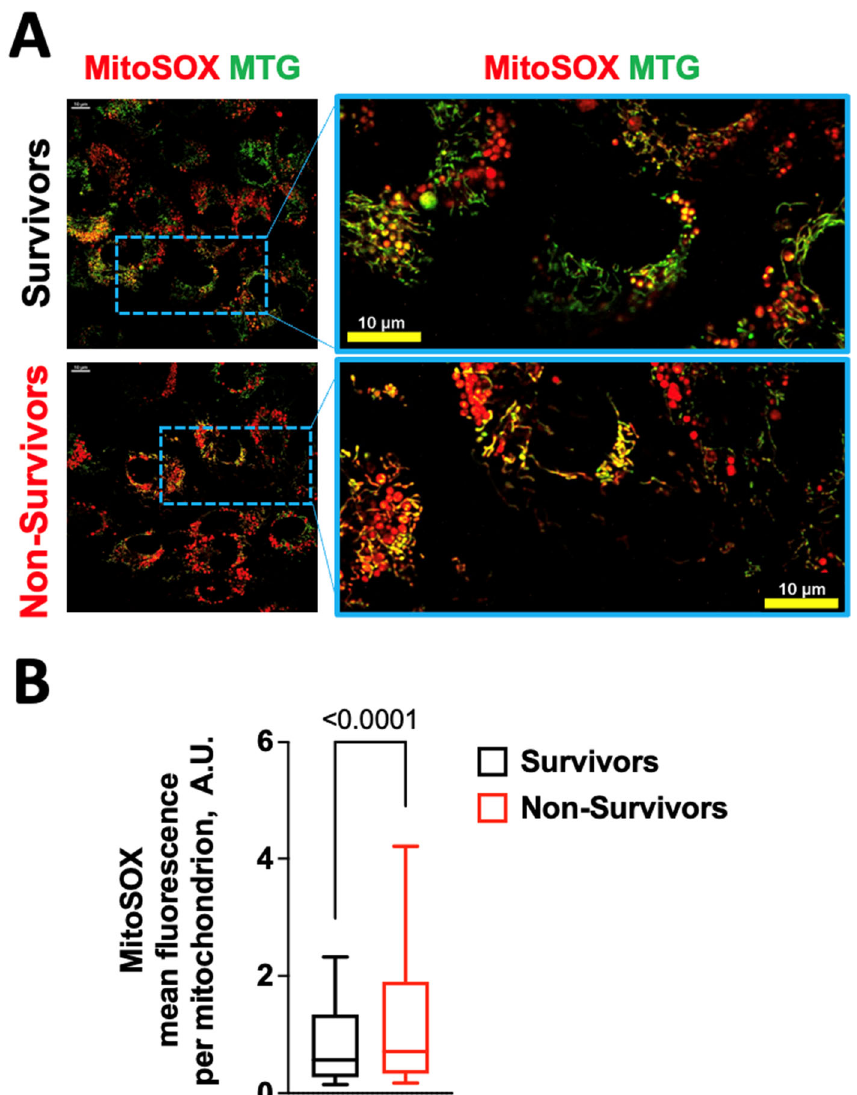
Figure 2. Serum from patients who did not survive COVID-19 increases mitochondrial ROS production. ( A ) Representative microphotographs of MitoSOX Red and MitoTracker Green FM (MTG) staining of HUVECs treated for 24 h with 10% serum from patients who survived or did not survive COVID-19. ( B ) Quantification of MitoSOX Red fluorescence intensity. Data are from at least three independent experiments and are presented as a box-and-whiskers plot showing the median and the 5 th –95 th percentiles; A.U.: arbitrary units.